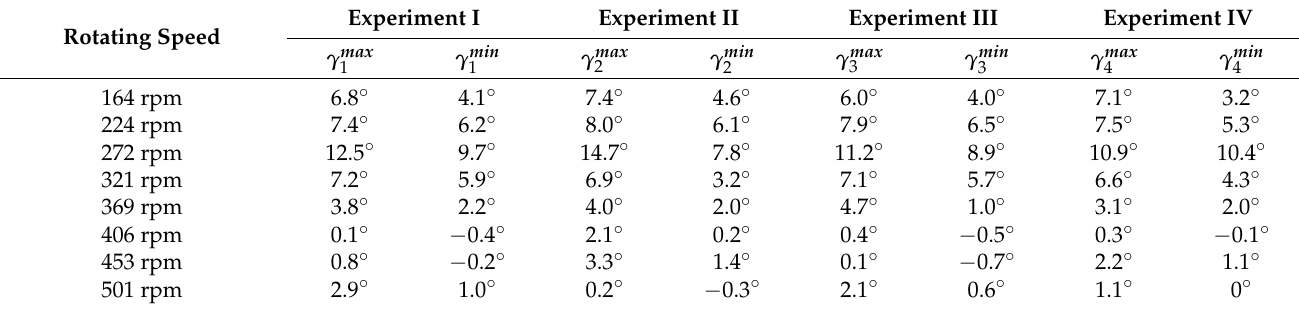
Table 2. The circumferential deflection angle of broken